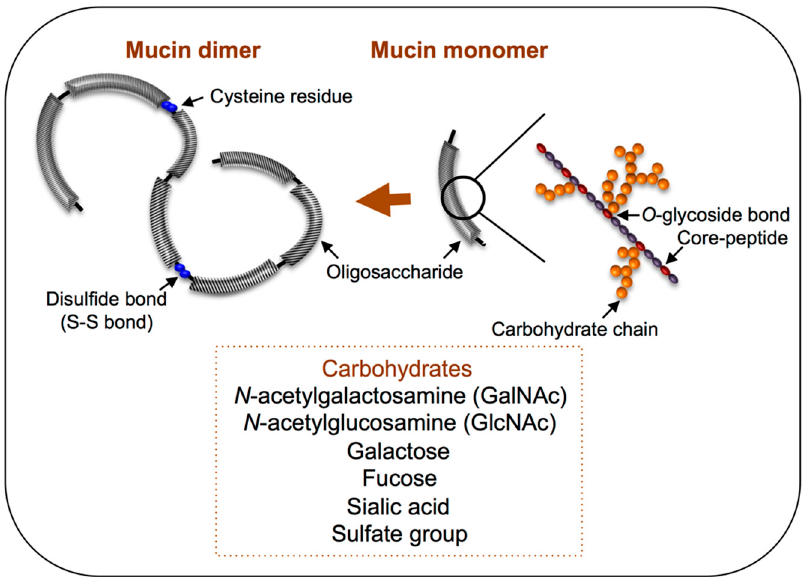
Figure 3. Polymeric structure of mucin molecules. A simplified scheme showing the composition of mucin glycoproteins, in monomer and dimer forms. Glycosylated regions are shown as black diagonal tubes, in which carbohydrate chains form a closely packed sheath around the central peptide core.